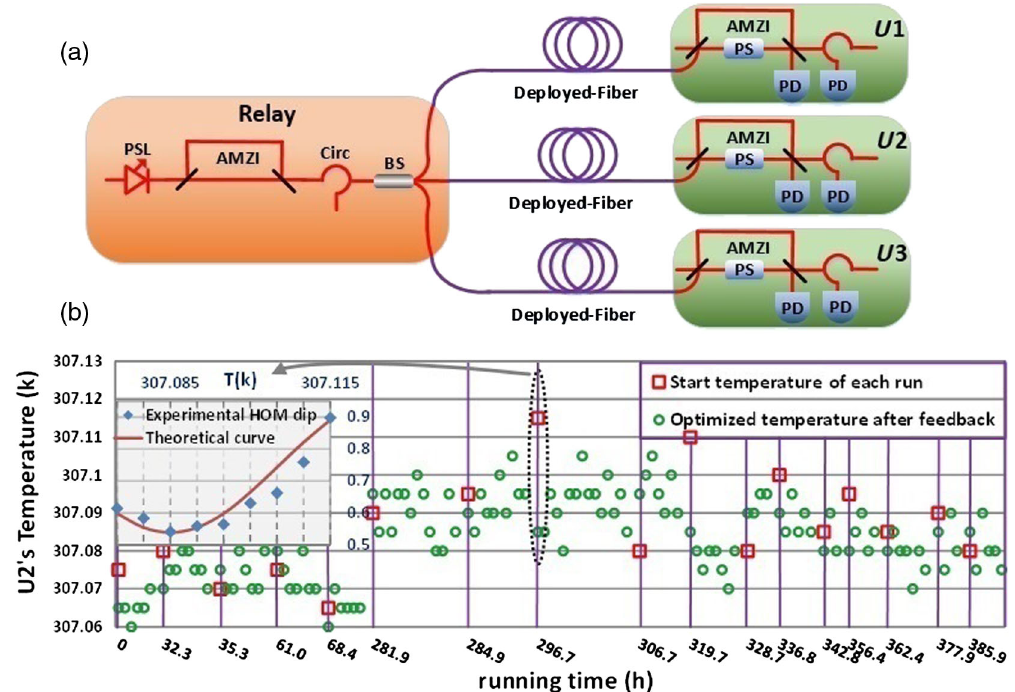
FIG. 3. (a) The structure of the phase-feedback scheme. A PSL placed in the relay passes through a reference AMZI with 6.5-ns delay and a circulator. It is divided into three parts by BS and then sent to each user ’ s AMZI, connected by an additional fiber, respectively. After the user ’ s AMZI, two photon detectors (here, we use commercial power meters) record the two output interference intensities and then provide a feedback signal to compensate the phase shift of AMZI by the phase shifter inside each user ’ s AMZI. (b) The wavelength calibration result via measuring HOM interference. The different vertical zone represents different runs of MDIQKD. The x axis represents the system running time, and the y axis represents the temperature for U2 ’ s laser in the case of user pair ( U 3 − U 2 ). Every green circle and red square point defines optimized temperature after a HOM dip measurement and the start temperature of each run. The inset shows the experimental HOM dip curve that we measure by scanning the